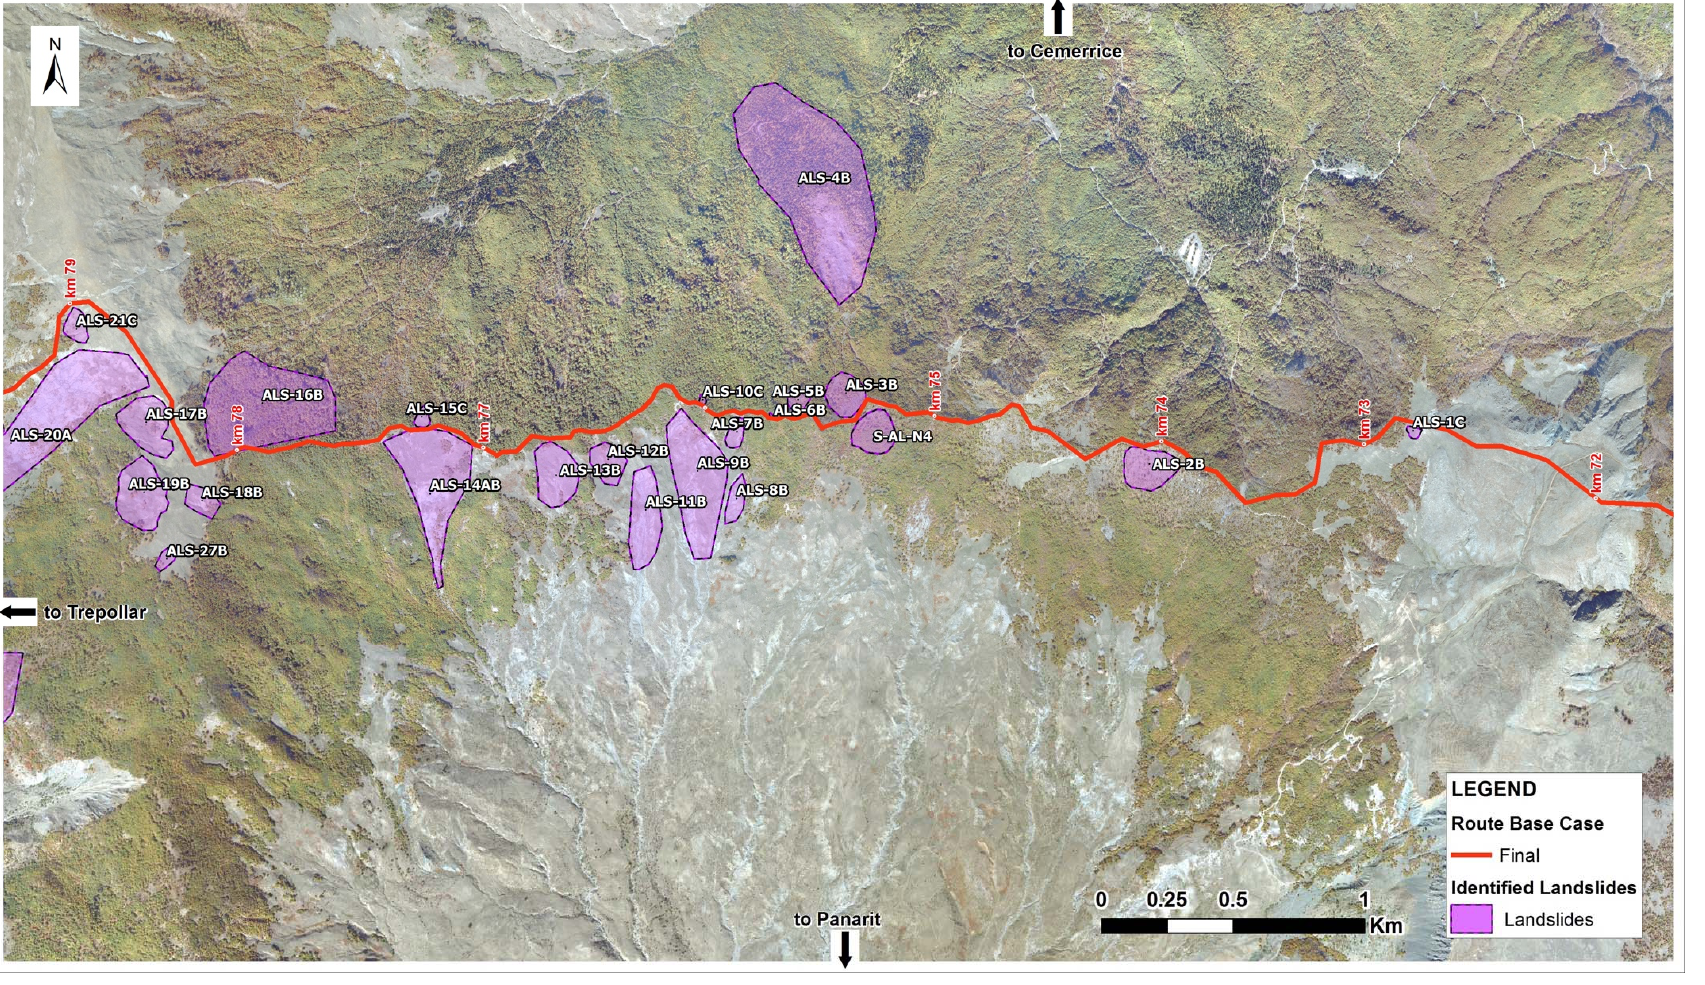
Figure 13. Landslide inventory for the TAP segment between 72 and 79km, where several landslides are located close to the TAP RoW, threatening pipeline integrity.